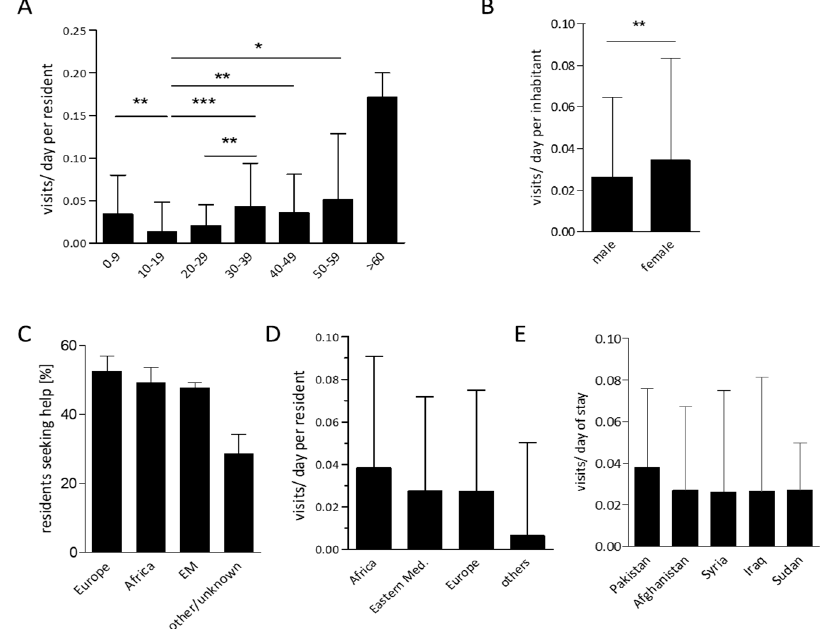
Figure 3. Factors influencing healthcare utilization in the analyzed cohort. Visits to the onsite medical ward per day of camp residence in age specific subgroups ( A ) and males vs. females ( B ). Percentage of asylum seekers utilizing medical help amongst all camp residents from this WHO region of origin ( C ). Medical consultations per day of camp residence in asylum seekers from different regions of origin ( D ) or from the top five most prevalent nations within the cohort ( E ) (bars display mean + IQR (A,B,D,E) and mean ± 95%CI (C), * p ≤ 0.05, ** p ≤ 0.01, *** p ≤ 0.005).